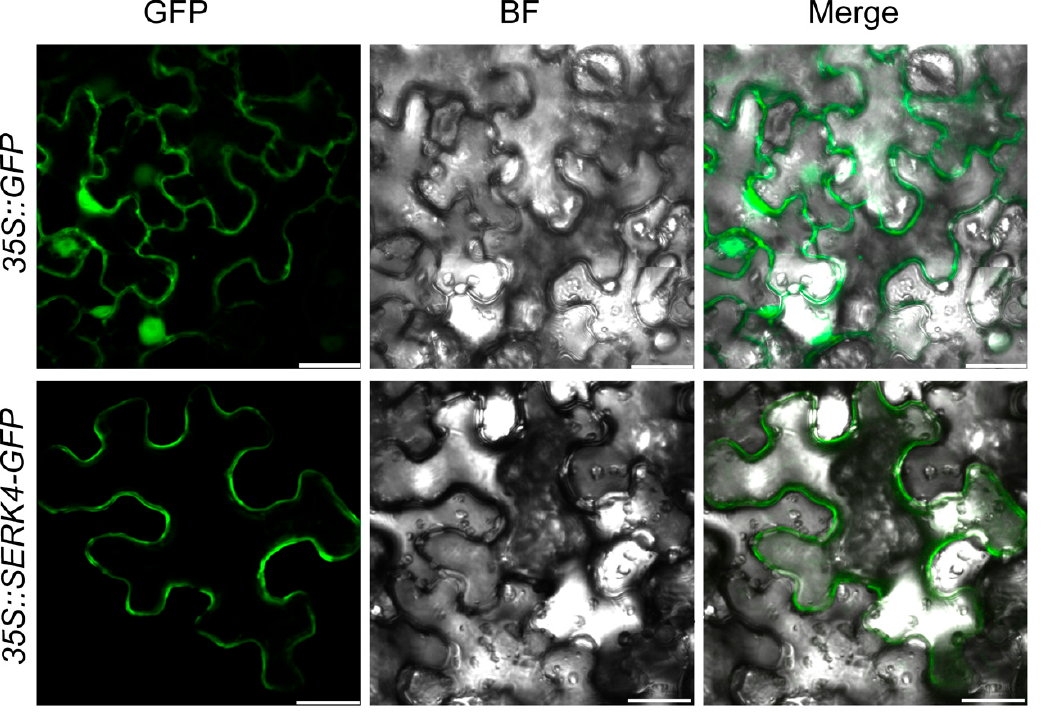
Figure 2. Subcellular localization analysis of the SERK4 protein: the green fluorescent protein (GFP) and SERK4-GFP fusion constructs under the control of the CaMV-35S promoter were transiently expressed in tobacco leaves. The scale bar represents 25 µm. GFP, GFP fluorescence; BF, bright field; Merge, the merged image of GFP and BF.